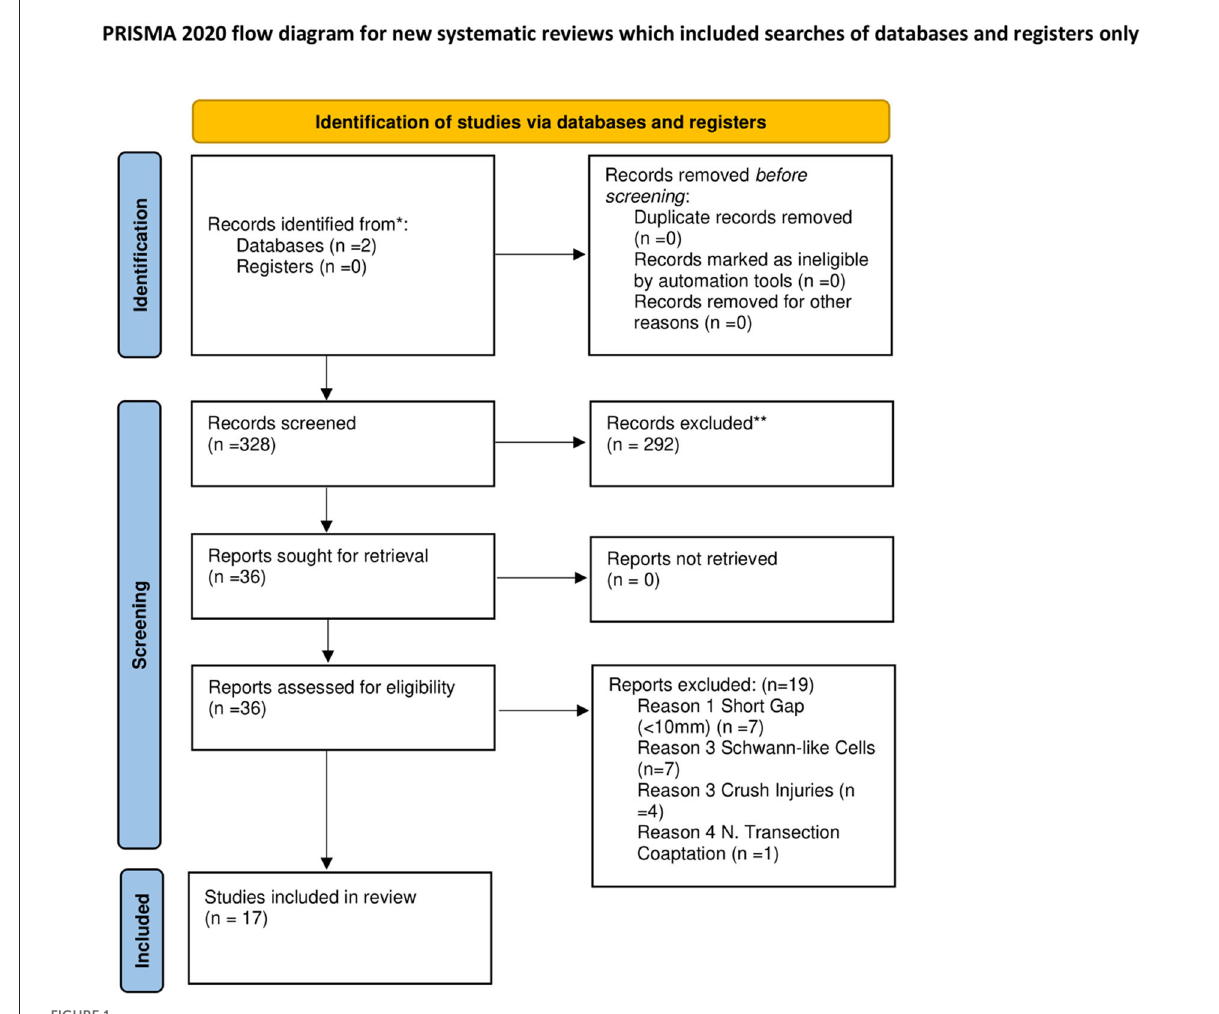
FIGURE1 Flowchart describing literature search and study selection. * Consider, if feasible to do so, reporting the number of records identified from each database or register searched (rather than the total number across all databases/registers). ** If automation tools were used, indicate how many records were excluded by a human and how many were excluded by automation tools. From Page et al.